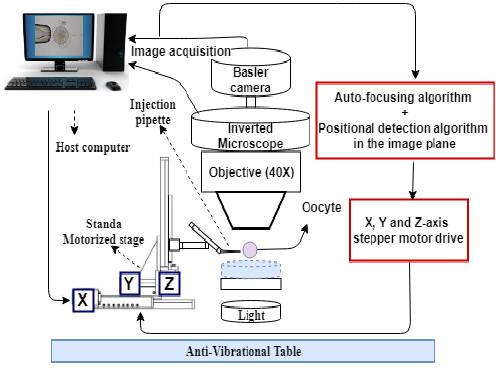
Figure 1. Schematic diagram of the cell-injection system setup.